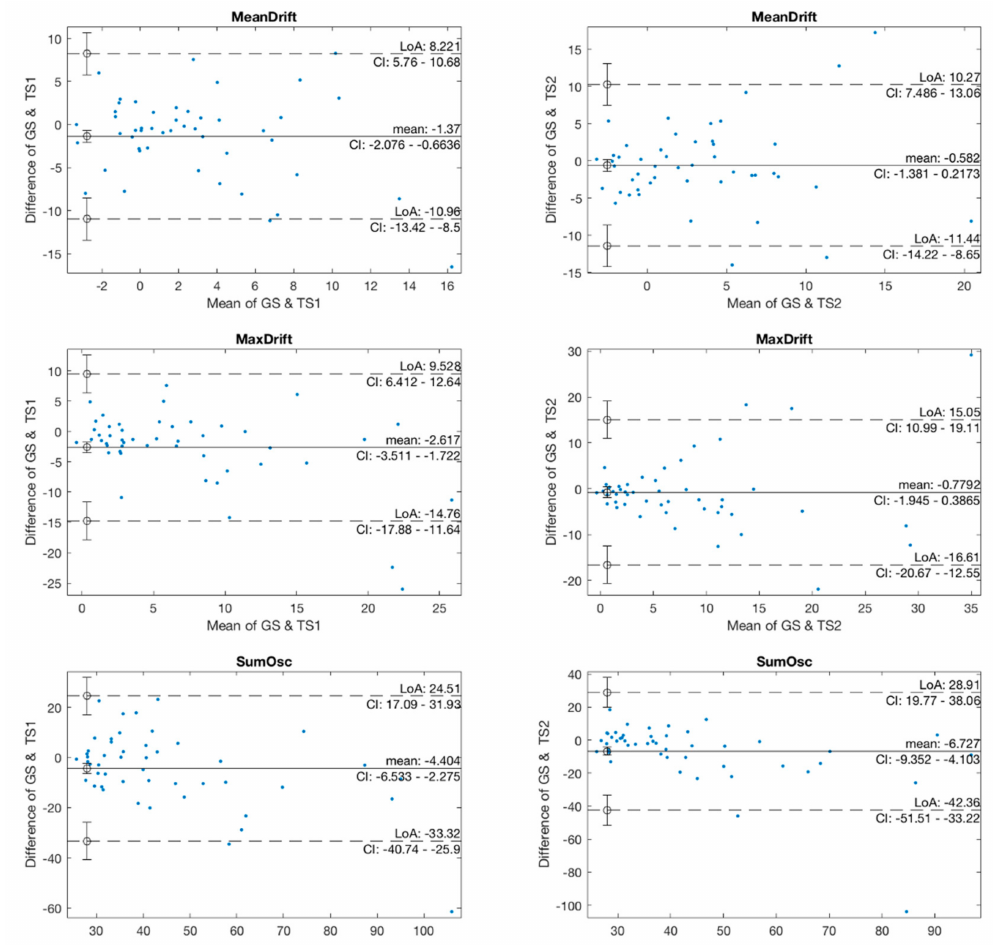
Figure 6. Bland-Altman plots of kinematic features.